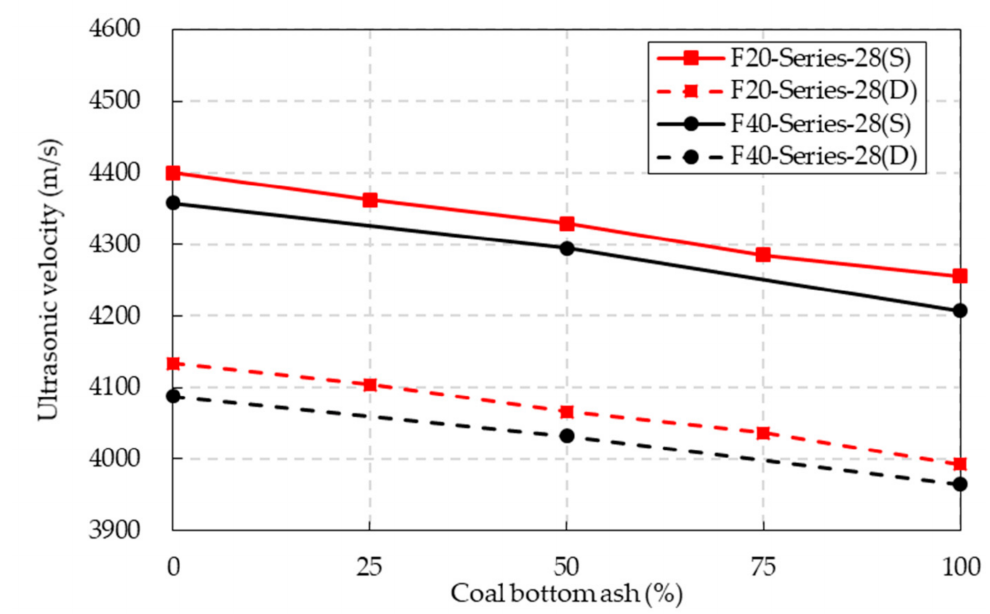
Figure 14. Ultrasonic velocity of the CBA